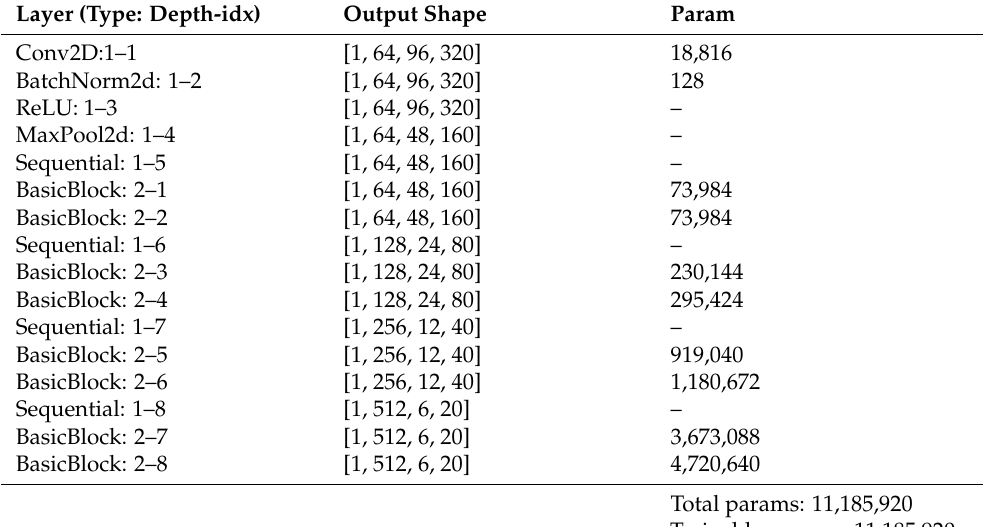
Figure 3. The modified approach with stereo pair in the encoder architecture. Losses are calculated based on the correct target frame from pair. Table 1. Model summary for encoder